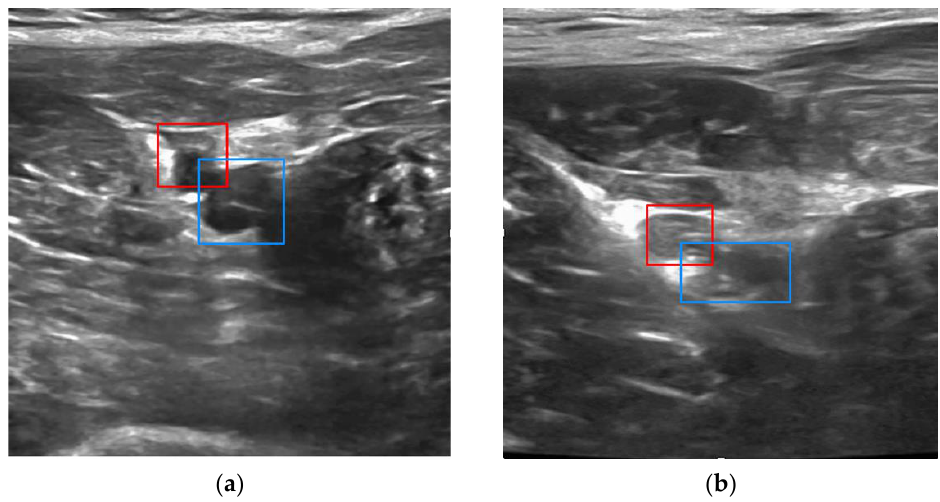
Figure 6. Examples of real-time vessel detection and classification, and bounding box placement in porcine study (femoral artery, red; femoral vein, blue) overlaid on ultrasound image: ( a ) normotensive condition and ( b ) hypotensive condition.